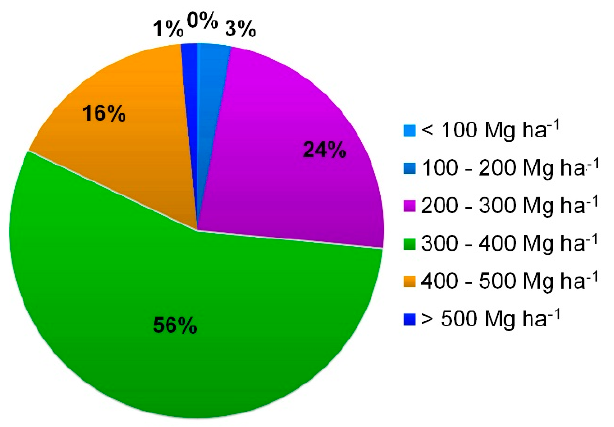
Figure 13. Distribution of AGB within the study area.